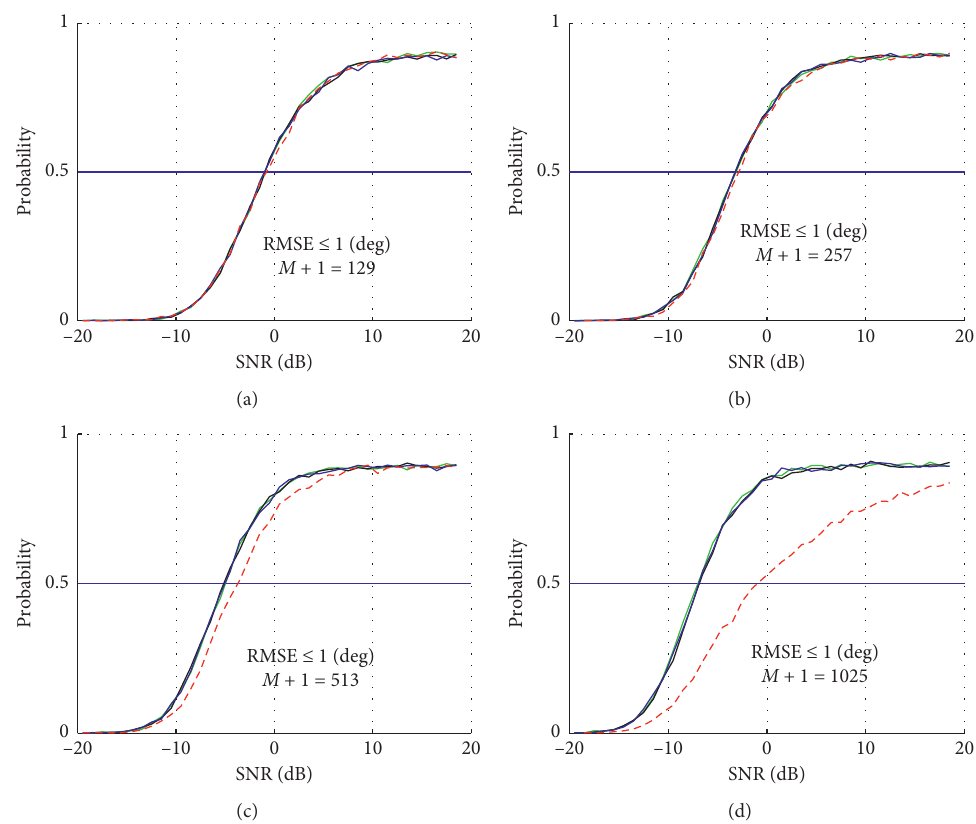
Figure 3: Probability of AoA measurement of Array-3, when RMSE ≤ 1 ° . Dashed line is WF-4